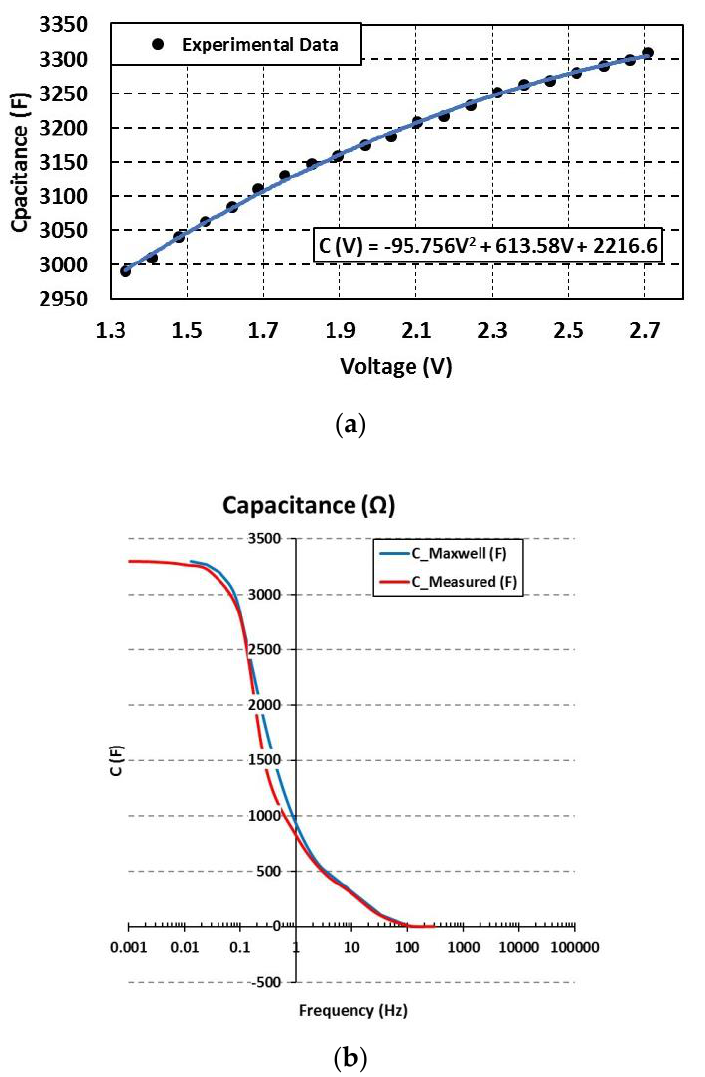
Figure 2. ( a ) Capacitance variation respect to the voltage; ( b ) Capacitance variation as a function of the frequency adapted from [7].